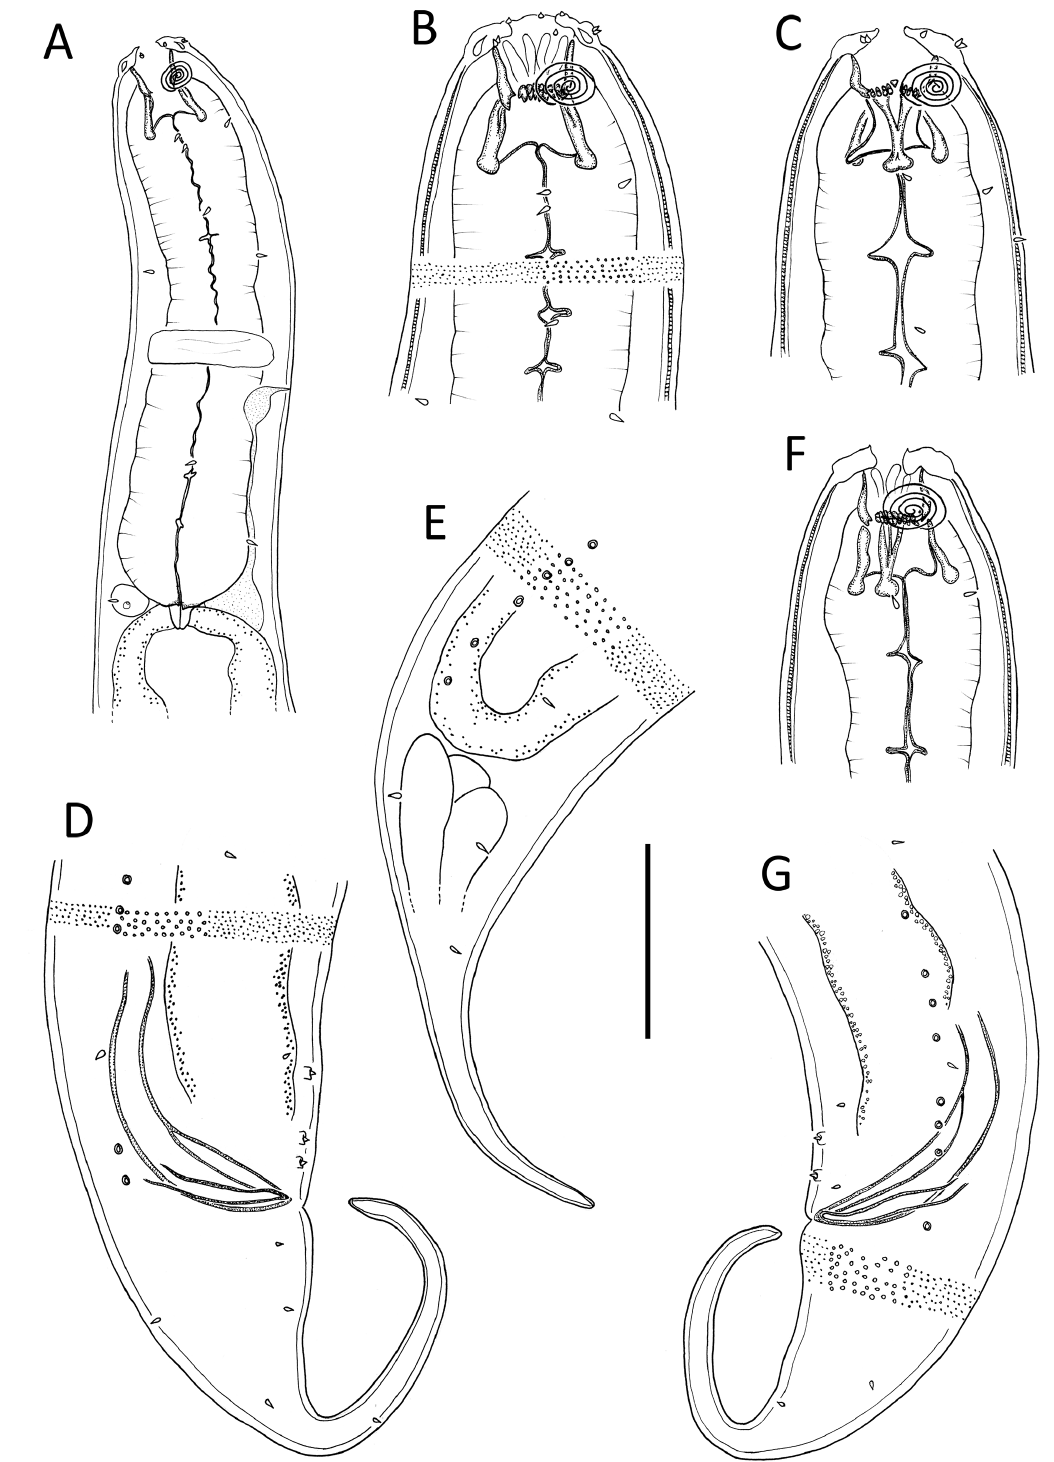
Fig. 4. Halichoanolaimus ossilagulus sp. nov. A . Holotype ♂ (NIWA 139246), anterior body region. B . Paratype ♀ (NIWA 139247), cephalic region. C . Paratype ♂ (NIWA 139247), cephalic region. D . Paratype ♂, posterior body region. E . Paratype ♀, posterior body region. F . Holotype ♂, cephalic region. G . Holotype ♂, posterior body region. Scale bar: A = 50 µm; B–C, E–F = 35 µm; D = 30 µm; G = 32